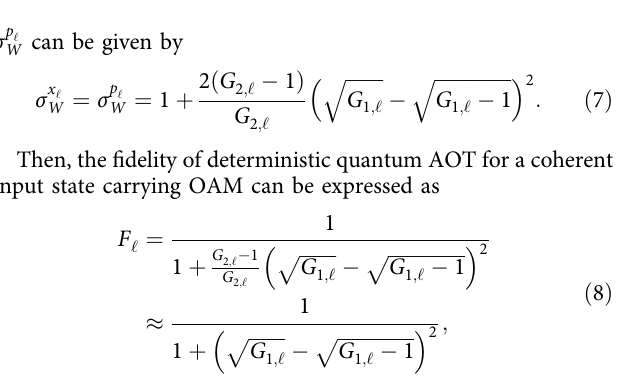
Fig. 2 Detailed experimental setup for parallel all-optical teleportation. a Alice, Bob, and Victor act as sender, receiver, and veri fi er of the all-optical teleportation (AOT), respectively. Alice and Bob are connected by an all-optical channel. ^ a Einstein-Podolsky-Rosen entangled state, 85 Rb vapor cell, HWP half wave plate, PZT piezoelectric transducer, PBS polarization beam splitter, AOM acousto-optic modulator, SLM spatial light modulator, GL Glan-Laser polarizer, GT Glan-Thompson polarizer, ^ a oscilloscope, 50:50 50:50 beam splitter, SA spectrum analyzer. The resolution bandwidth (RBW) of the SA is 1 MHz. The video bandwidth (VBW) of the SA is 100 Hz. b Energy level diagram of 85 Rb D 1 line for four-wave mixing (FWM) process in our scheme. Δ one-photon detuning, δ two-photon